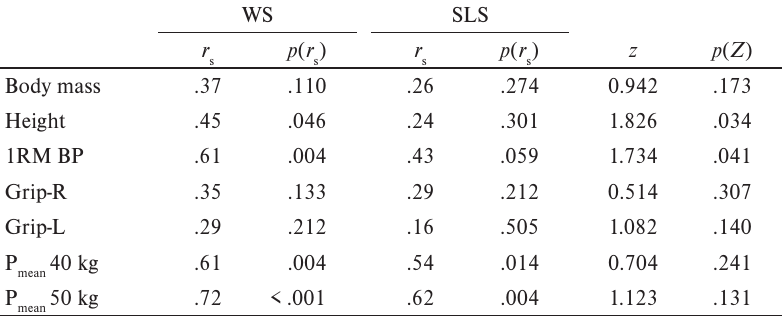
Correlations between various variables in the wrist shots and slap shots with peak velocity and significance of difference between these